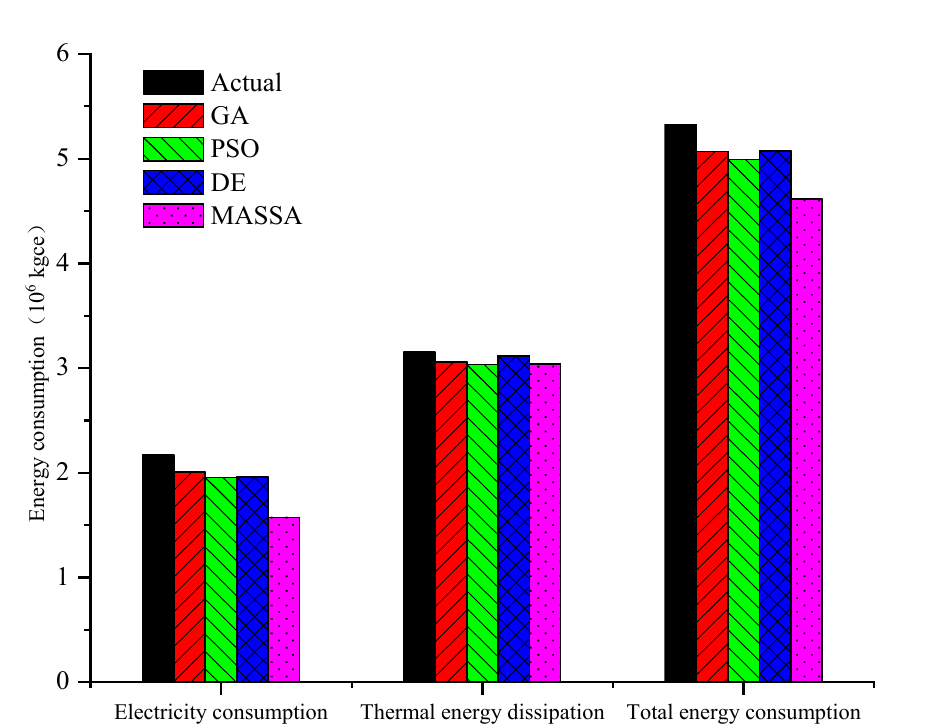
Figure 7. Energy consumption comparison between the actual scheme and the four algorithms’ simulation operation schemes.